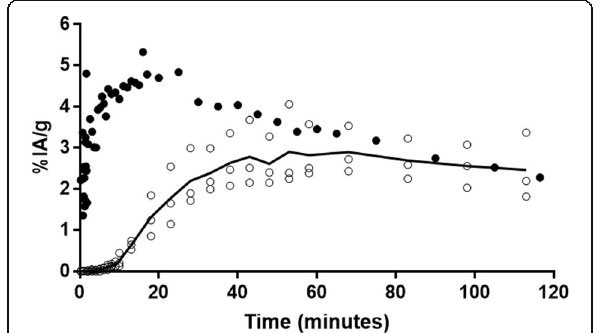
Fig. 5 Bone uptake of [ 18 F]-FLT following i.v. (full circles) or i.t. (solid line with open circles, n=3) administration. Data obtained from ROI traced on the forepaw bones and spine. The data are not corrected for 18 F decay